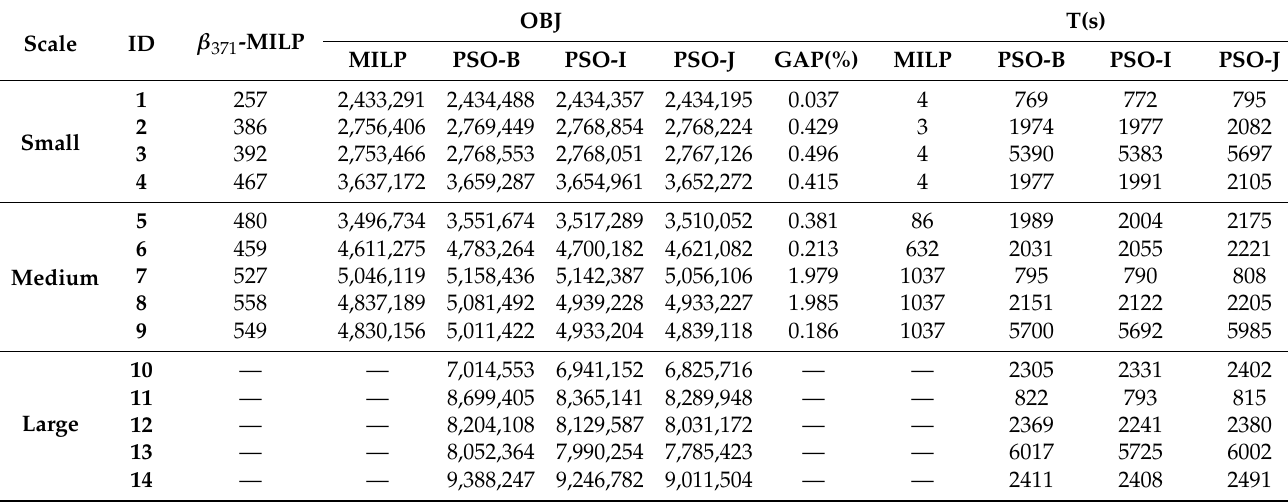
Table 1. The experimental results. “ β 371 -MILP” represents the number of containers transported to port 3 by number 7 feeder type 1. The results in Table 1 show that CPLEX is limited when handling large-scale problems. The two logical paths for generating the initial feasible particles (PSO-B and PSO-I) have nearby running times and have only a small influence on the optimal solutions. The quality of the optimal solutions and the running time of the improved PSO algorithm is the best.